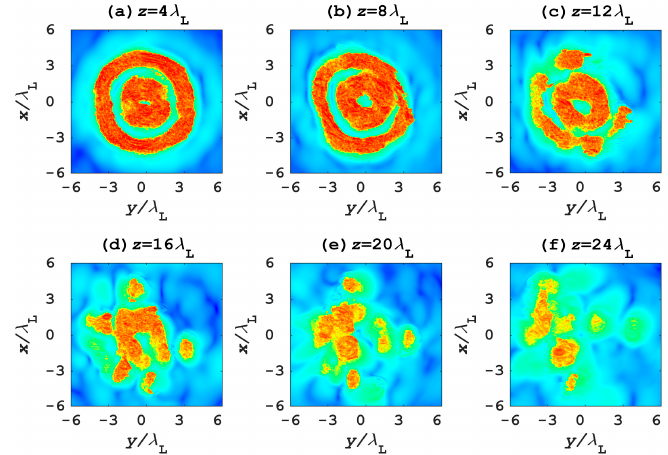
Figure 6. The cross-sectional views of the light-field magnitude profiles of the high-power double-ring-shaped LG 2 laser beam in plasma at the several specified propagation distances ( a ) z = 4 λ L , 1 ( b ) z = 8 λ L , ( c ) z = 12 λ L , ( d ) z = 16 λ L , ( e ) z = 20 λ L and ( f ) z = 24 λ L from the beam waist (see Video S4). The colormap bars of all the sub-figures are the same as that of Figure